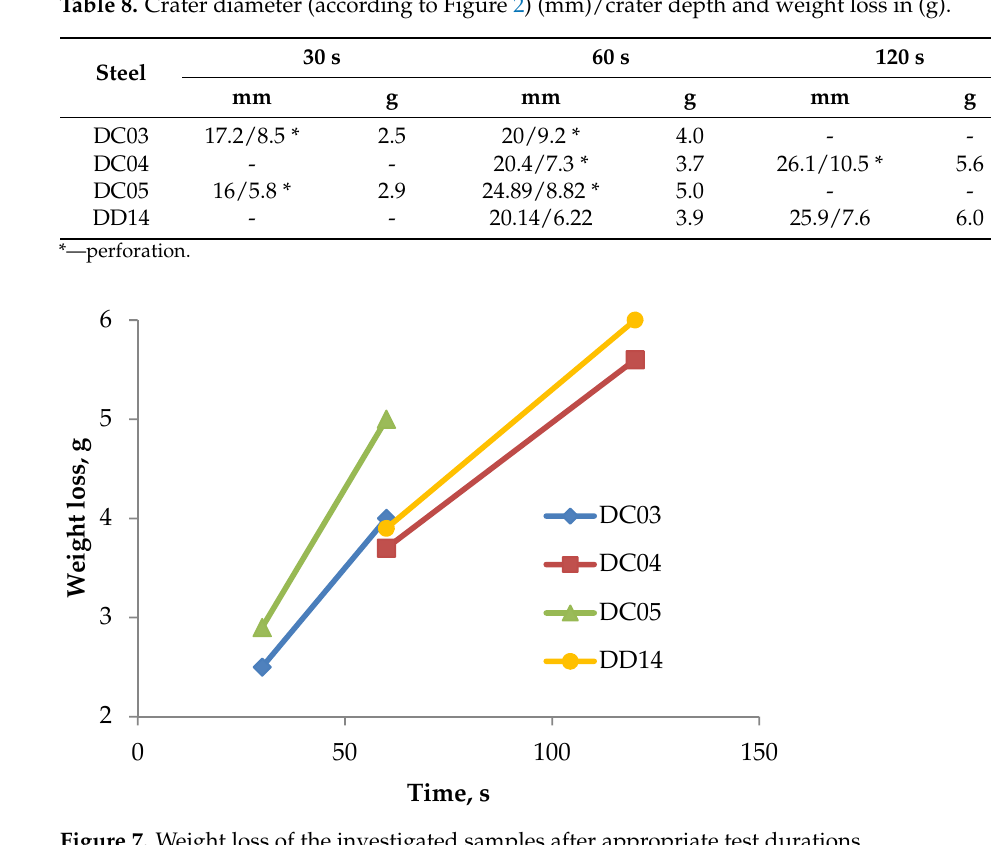
Figure 7. Weight loss of the investigated samples after appropriate test durations.